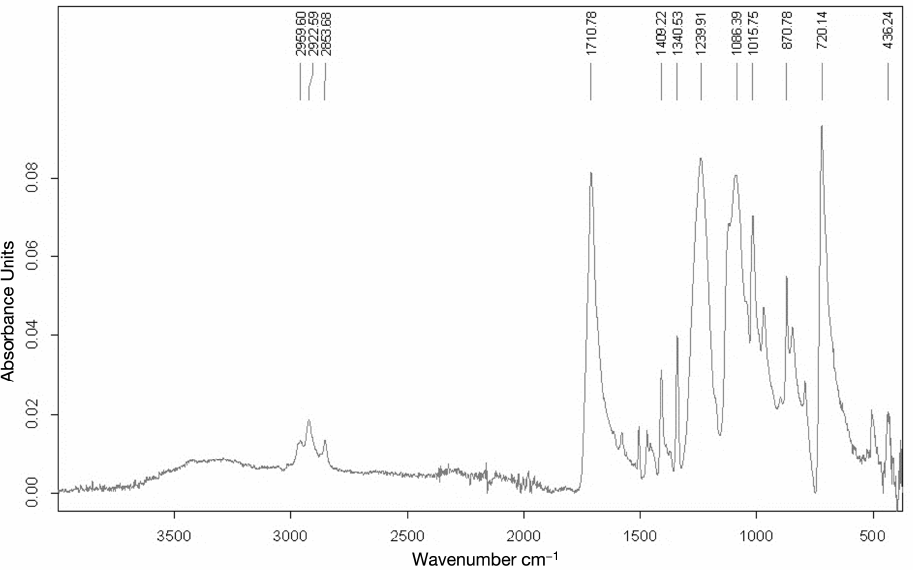
Figure 7. FTIR analysis of v-PET. Table 6. Wavenumbers and respective identifiable functional groups for v-PET [24,25].